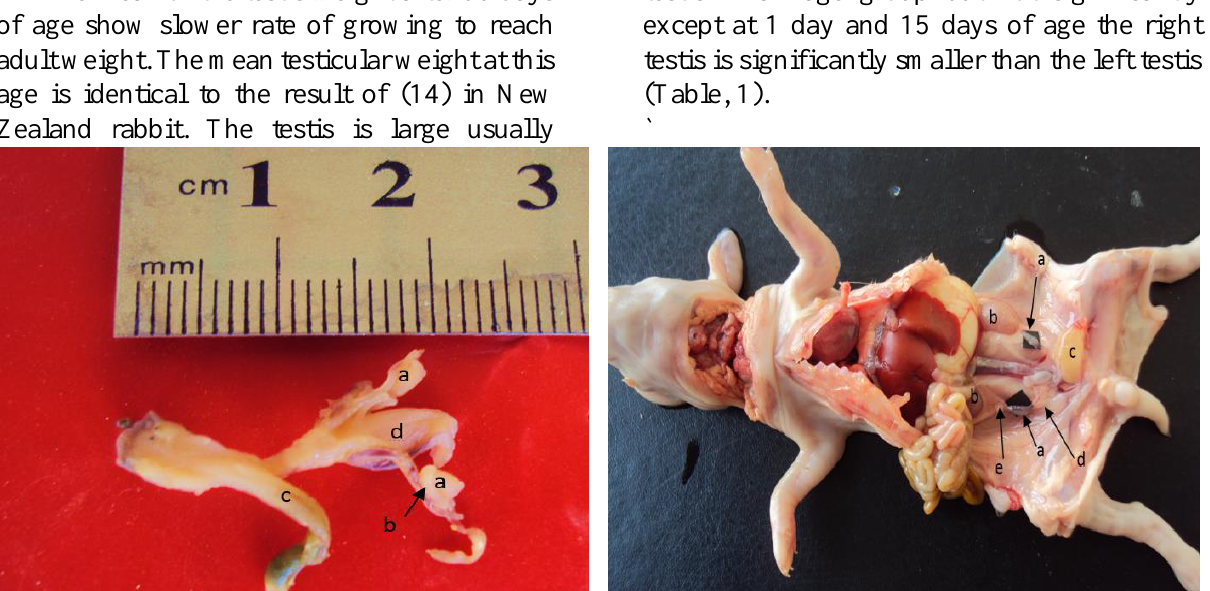
Figure, 3:Urogenital system of the Kit rabbit at 15- days age, shows the shape of the testes and epididymis a- testis b- epididymid c- rectum d- urinary bladder e- seminal vesicle gland.